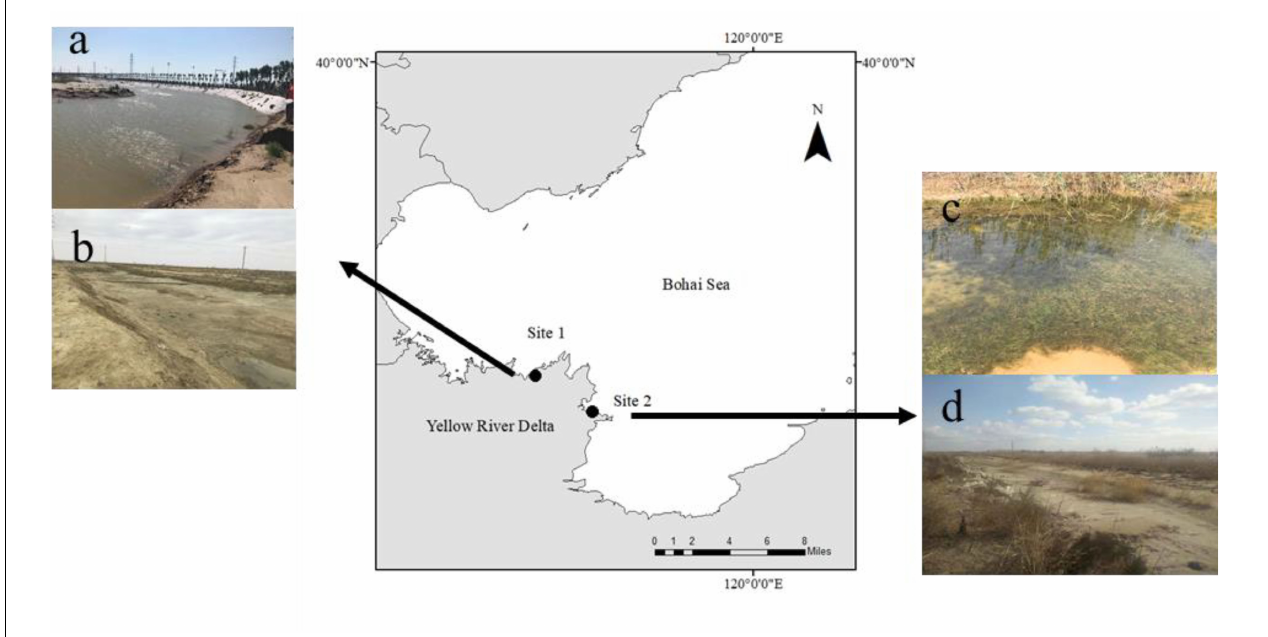
FIGURE 1 | Study sites in the Yellow River Delta. (a) high water levels at Site 2 in August 2017; (b) extreme desiccation period at Site 2 in March 2018; (c) high water level at Site 1 in May 2017; and (d) dry season at Site 1 in December